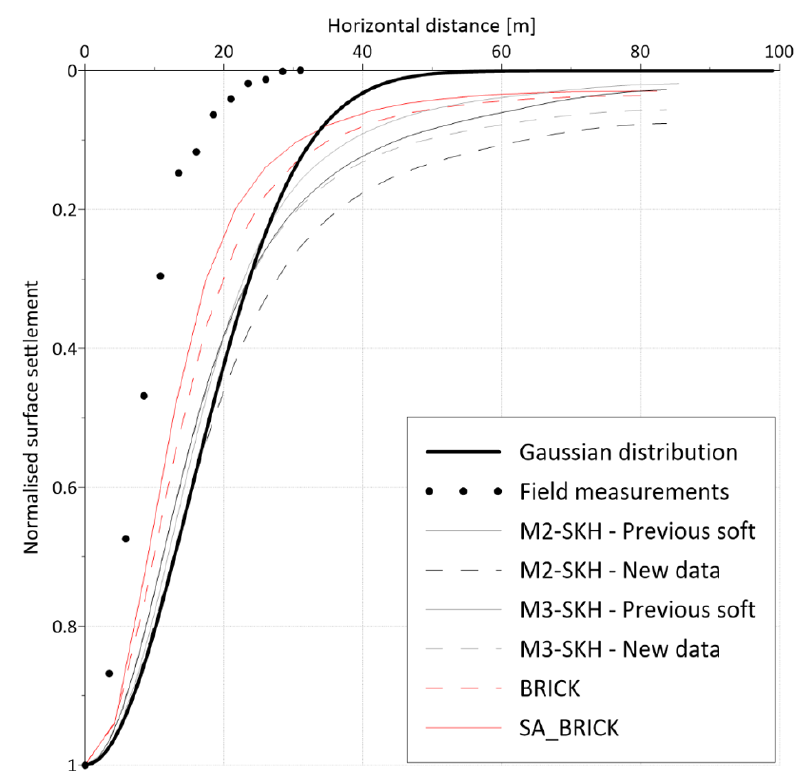
Figure 17. Normalized diagrams of the results of modelling of the excavation of the east tube compared with the Gaussian distribution and field data.